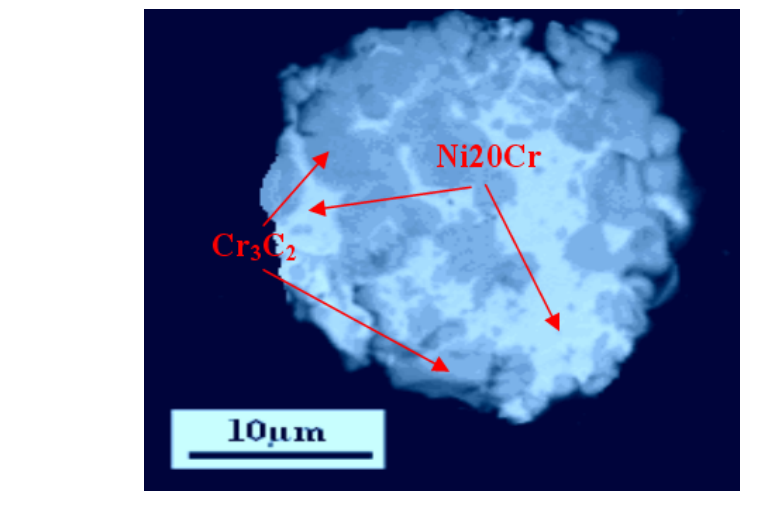
Figure 1 – (SEM) Scanning electron micrograph of Cr 3 C 2 - 25(Ni20Cr) powder particles Slika 1 – (SEM) Skening elektronska mikrografija č estica praha Cr 3 C 2 - 25(Ni20Cr) Рис . 1 – (SEM) Электронная микрография частиц порошка Cr 3 C 2 -